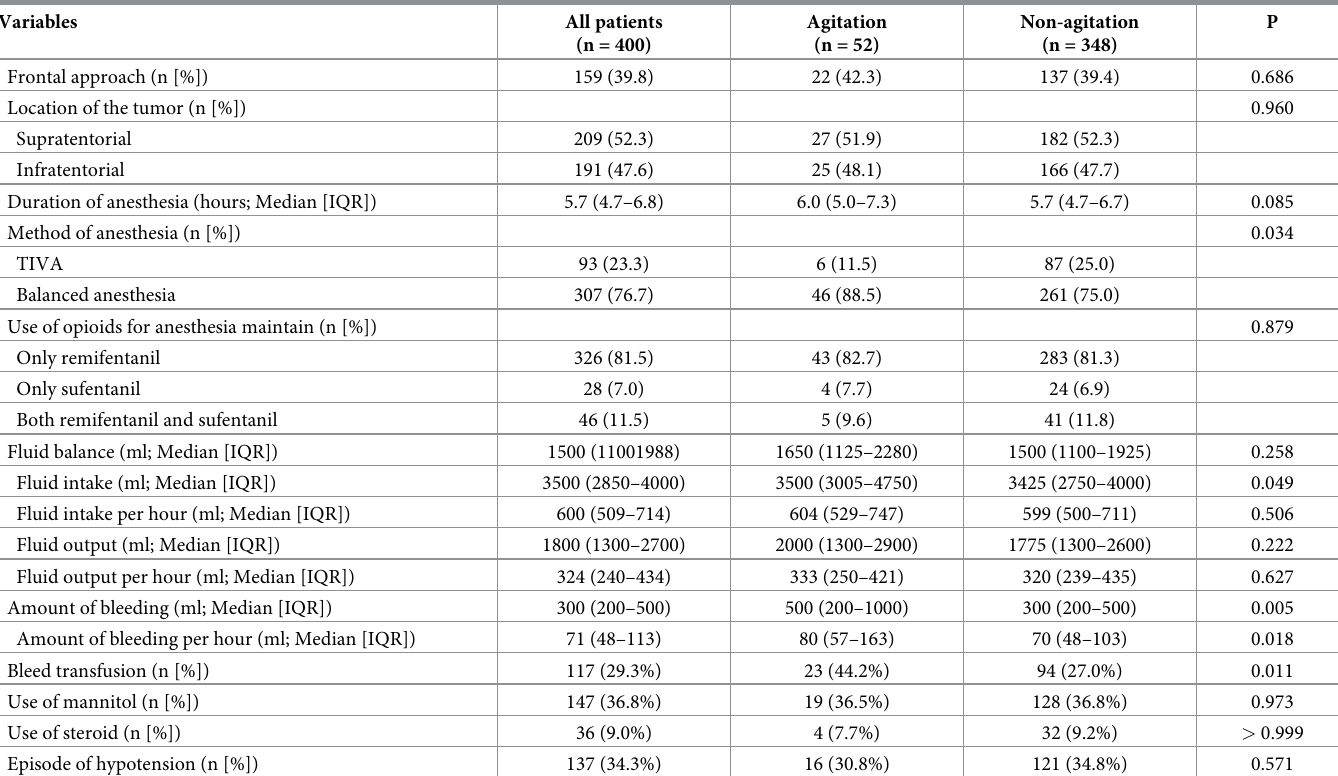
Table 2. Univariable analyses of intraoperative